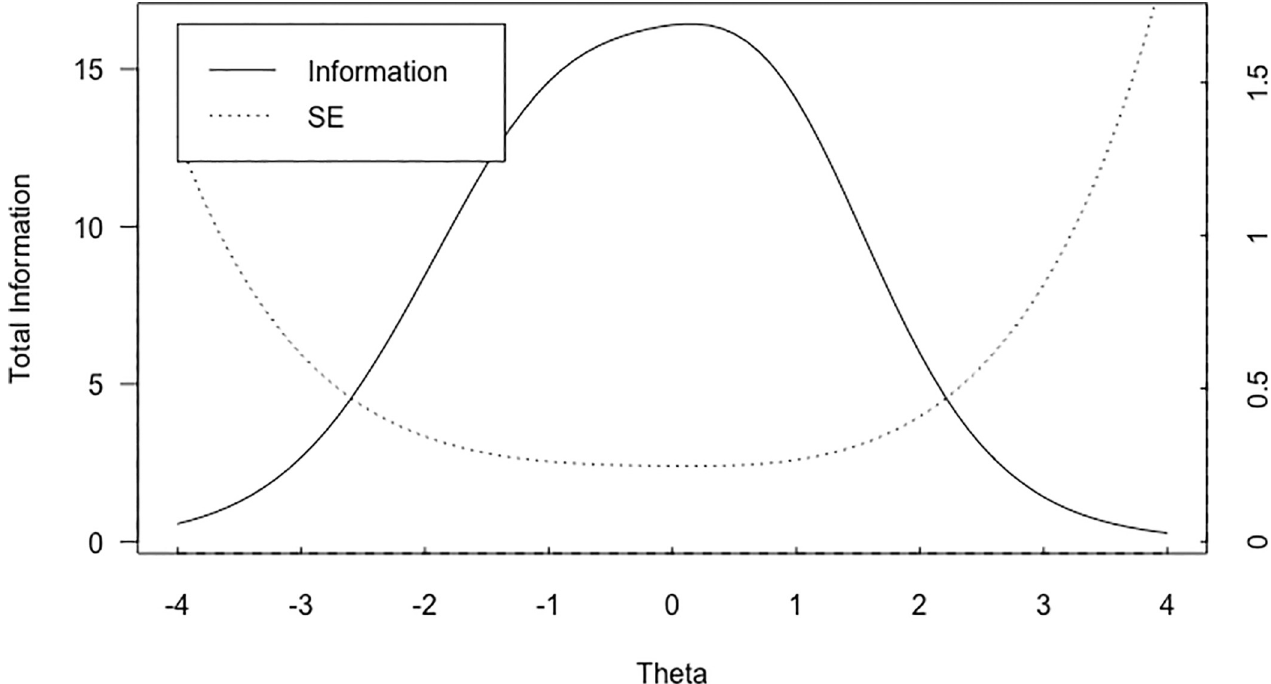
Fig 3. Overall scale information and standard error. Key–SE = Standard Error.